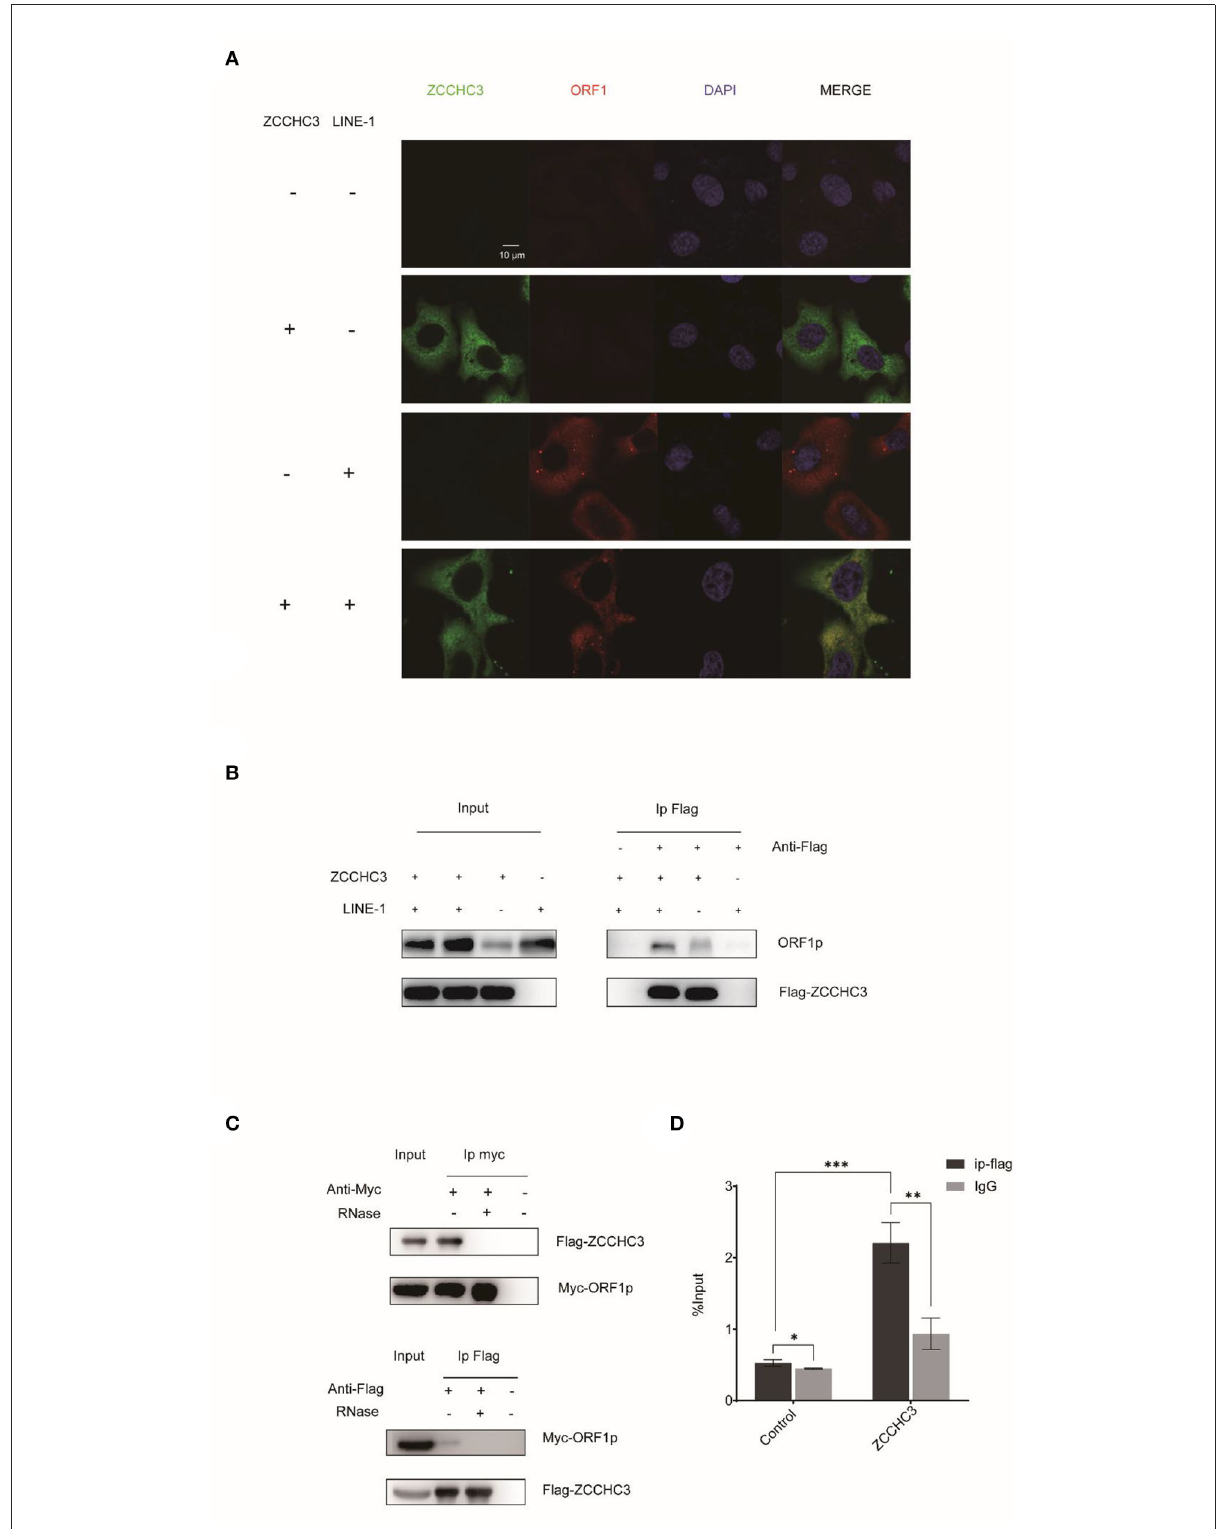
FIGURE4 ZCCHC3 interacts with LINE-1 in the cytoplasm. (A) ZCCHC3 is co-located with LINE-1 ORF1p. Hela cells were transfected with pWA367 plasmid and Flag-ZCCHC3 DNA. Forty-eight hours post-transfection, LINE-1 ORF1p and Flag ZCCHC3 were detected by